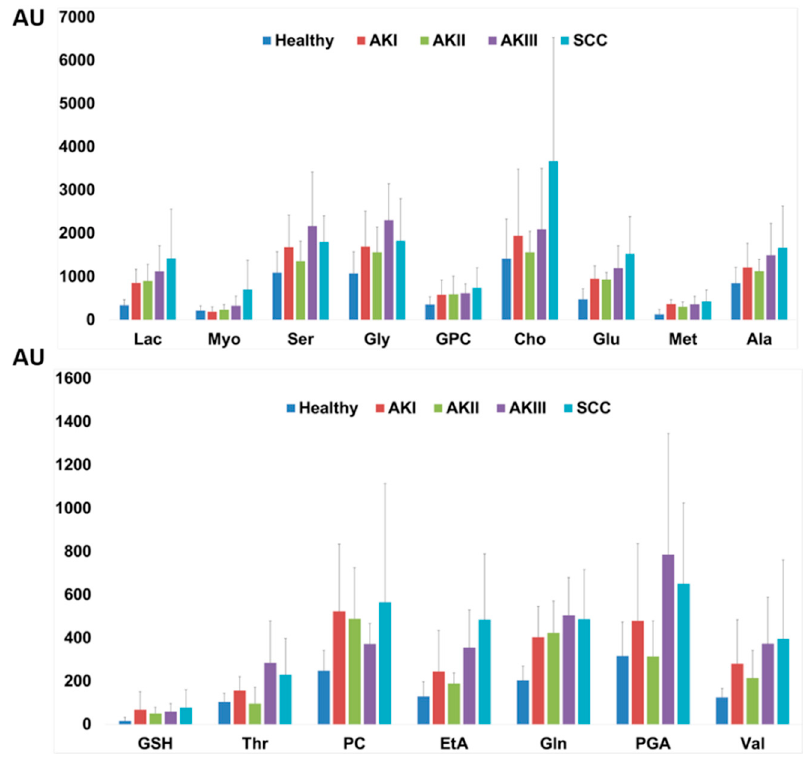
Figure 4. Selected small metabolites highlighted by qualitative multivariate analysis were deconvoluted and quantified from 1 H CPMG spectra and the mean ± SD are reported. The following metabolites are reported on the X axes: lactate (Lac), myo-inositol (Myo), serine (Ser), glycine (Gly), glycerophosphocholine (GPC), choline (Cho), glutamate (Glu), methionine (Met), alanine (Ala), glutathione (GSH), threonine (Thr), phosphocholine (PC), ethanolamine (EtA), glutamine (Gln), pyroglutamic acid (PGA), valine (Val). Y axes—arbitrary units.